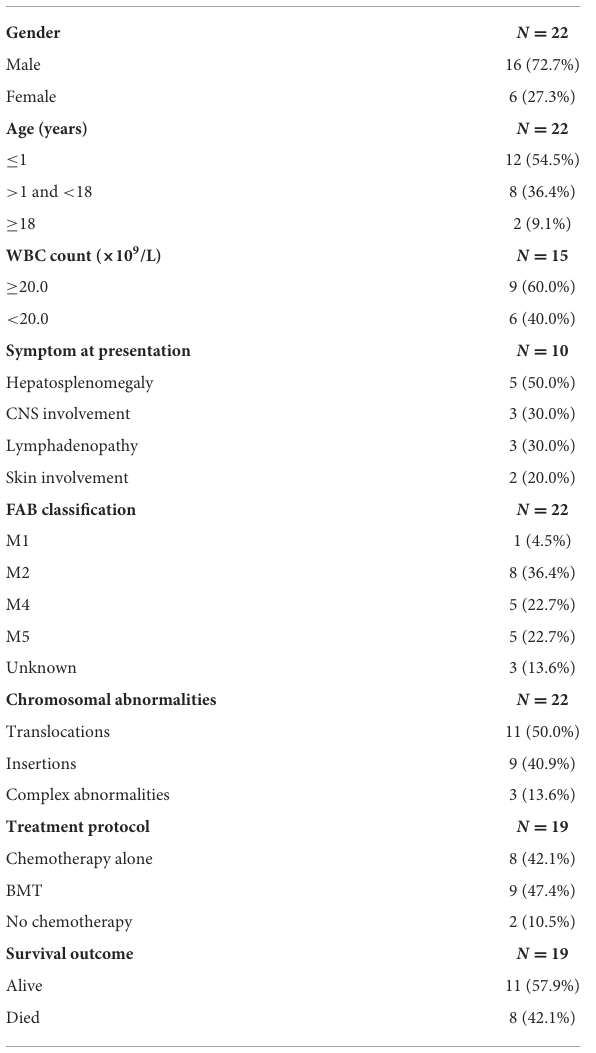
TABLE 3 Clinical features of evaluable